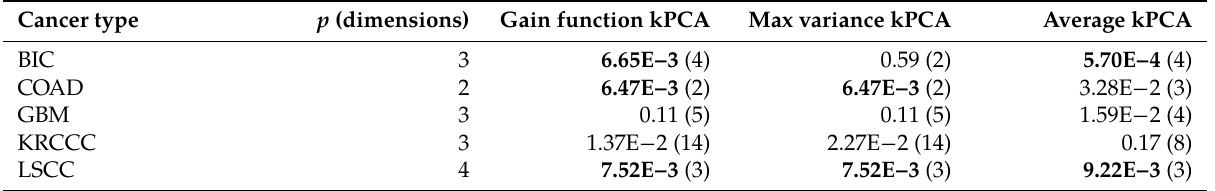
Table 1: Survival analysis of clustering results of kPCA used with an integrated kernel (gain function PCA), the kernel with the largest variance in the first p dimensions (max variance PCA) and average kernel PCA (average kPCA). Cancer